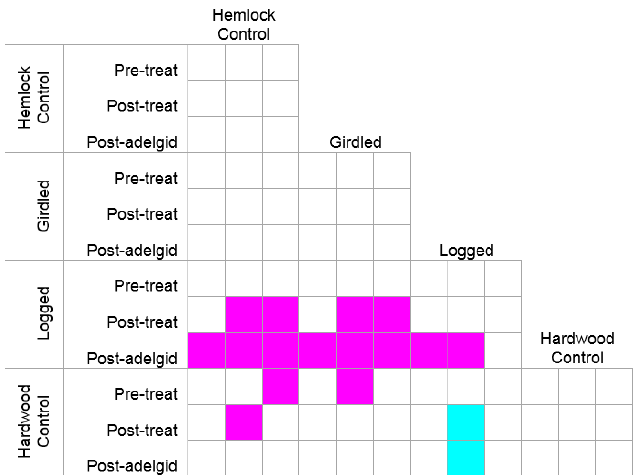
Figure 4. Post-hoc , pair-wise comparisons (Tukey’s Honest Significant Difference Test) of the response (principal axis 3) to canopy manipulation treatments (hemlock control, girdled, logged, and hardwood control) repeated within temporal strata (pre-manipulation (2003–2004); post-manipulation but prior to adelgid colonization (2005–2009); and after the adelgid had colonized the plots (2010–2014)). For each pair-wise comparison, differences between PC-3 of a given row and PC-3 of a given column are significantly greater than (magenta) or less than (blue) zero ( p ≤ 0.05).